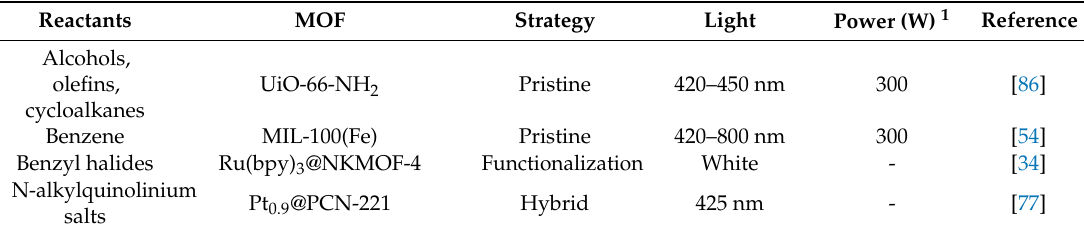
Table 9. Various photooxidation reactions mediated by MOFs.